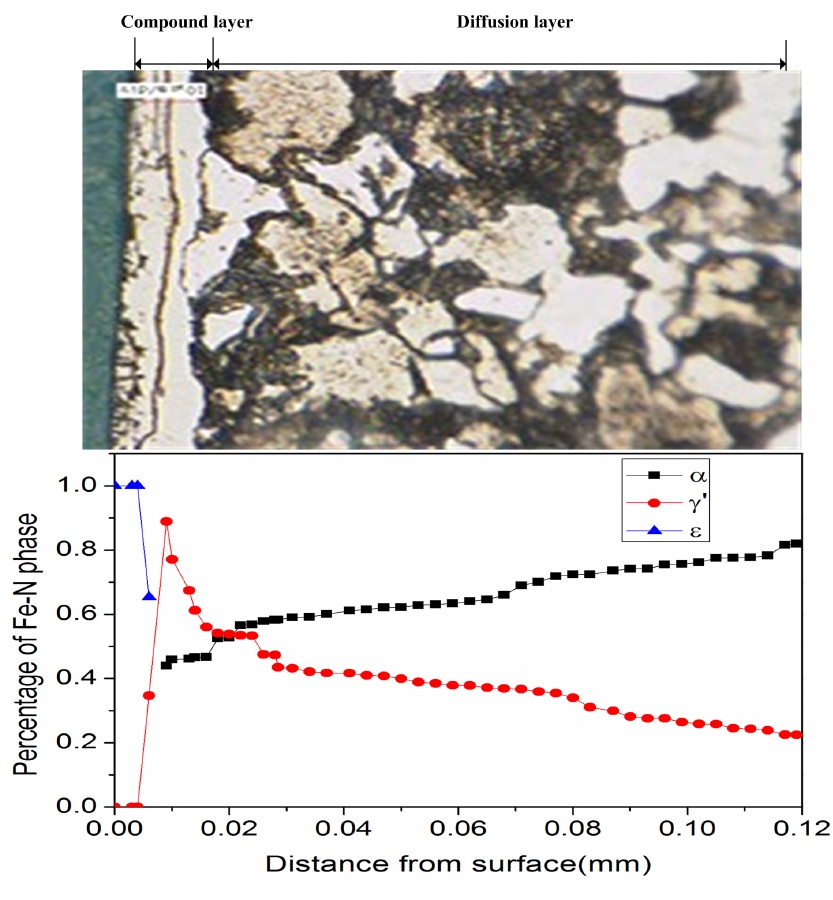
Fig. 5 Volume fraction of the Fe-N phase in SCr420H steel.